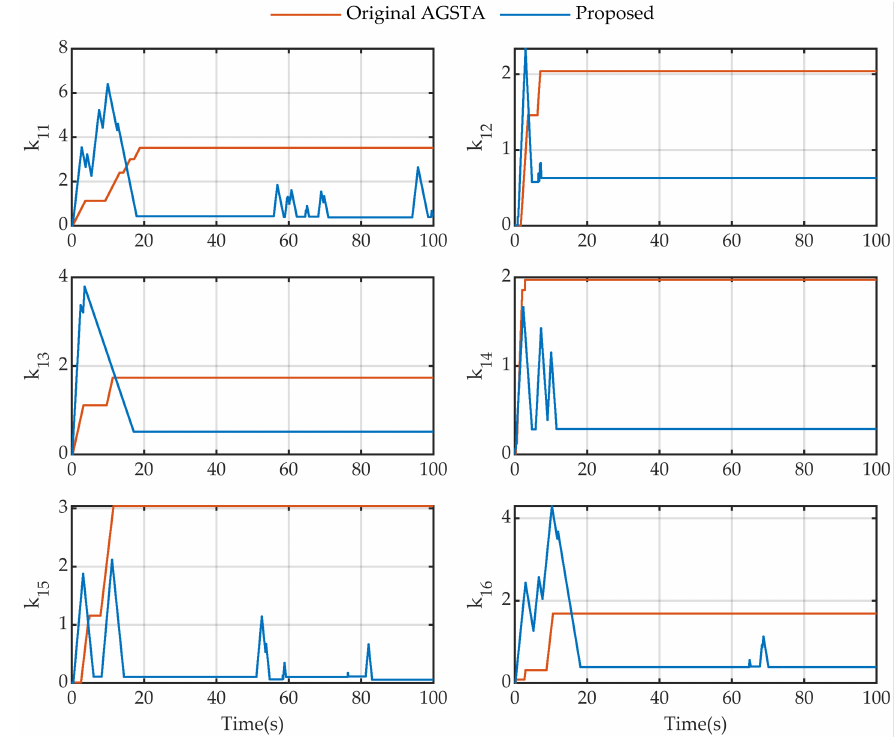
Figure 9. Evolution of the adaptive gains k 1 (t) over time.